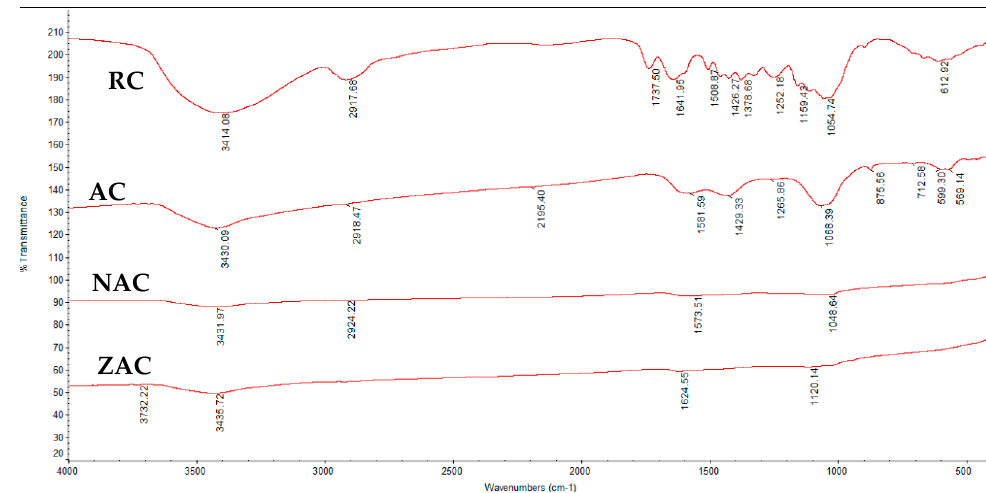
Figure 3. The FTIR spectra for all types of cassava stem adsorbents.